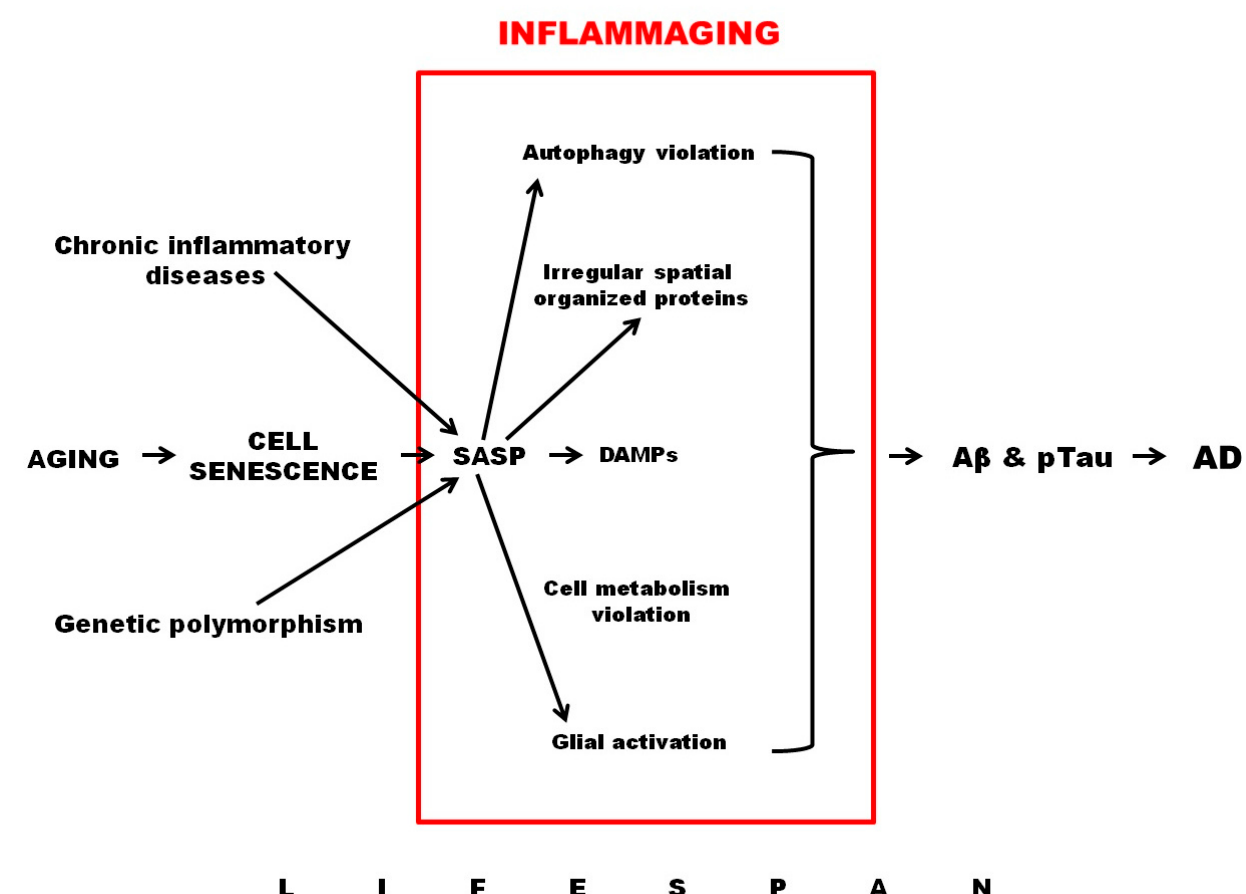
Figure 2. Role of inflammaging in AD development.